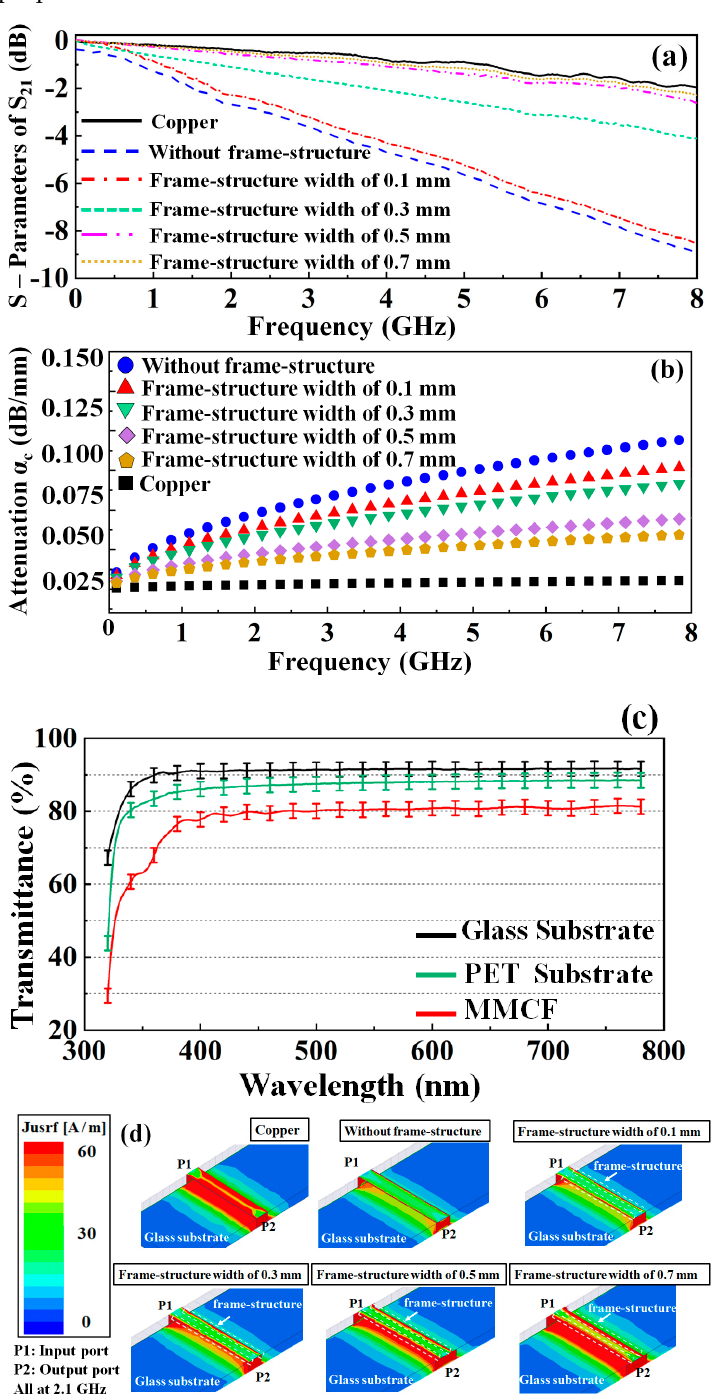
Figure 1. Comparison of the ( a ) measured |S 21 | and ( b ) calculated conductor losses ( α c ) ( c ) transparency conditions of glass, PET, MMCF, and ( d ) surface current distributions of MMCF − based microstrip lines using a different frame structure.